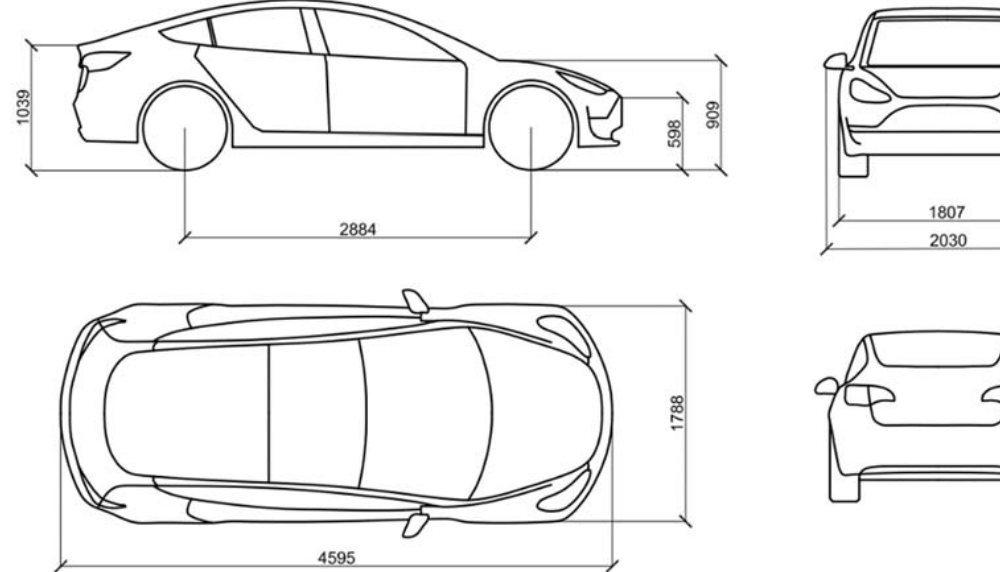
Figure 3. Vehicle dimensions.